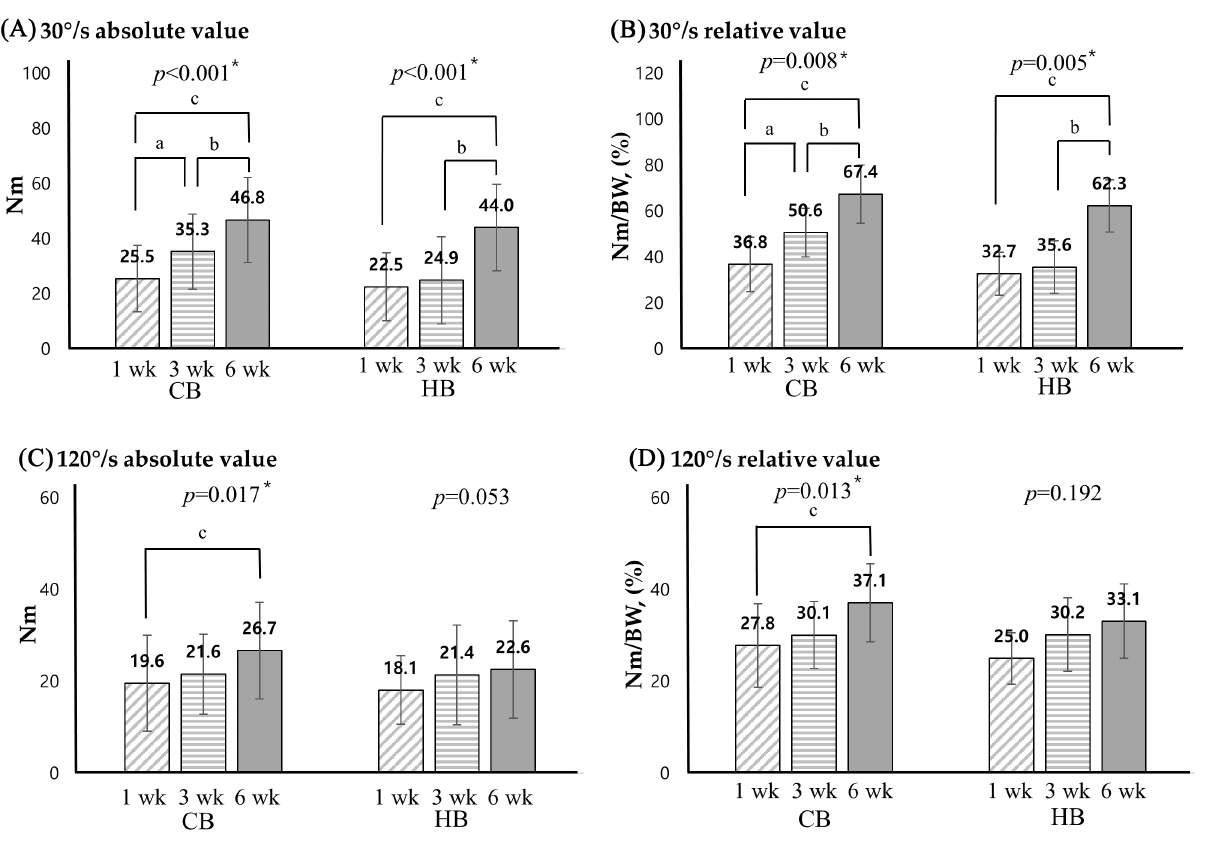
Fig. 2. Isokinetic eversion strength of CB training and HB training groups. * p < 0.05; a, b, and c mean the significance between measurement weeks (a, 1 week versus 3 weeks; b, 3 weeks versus 6 weeks; c, 1 week versus 6 weeks); CB, center-based; HB,